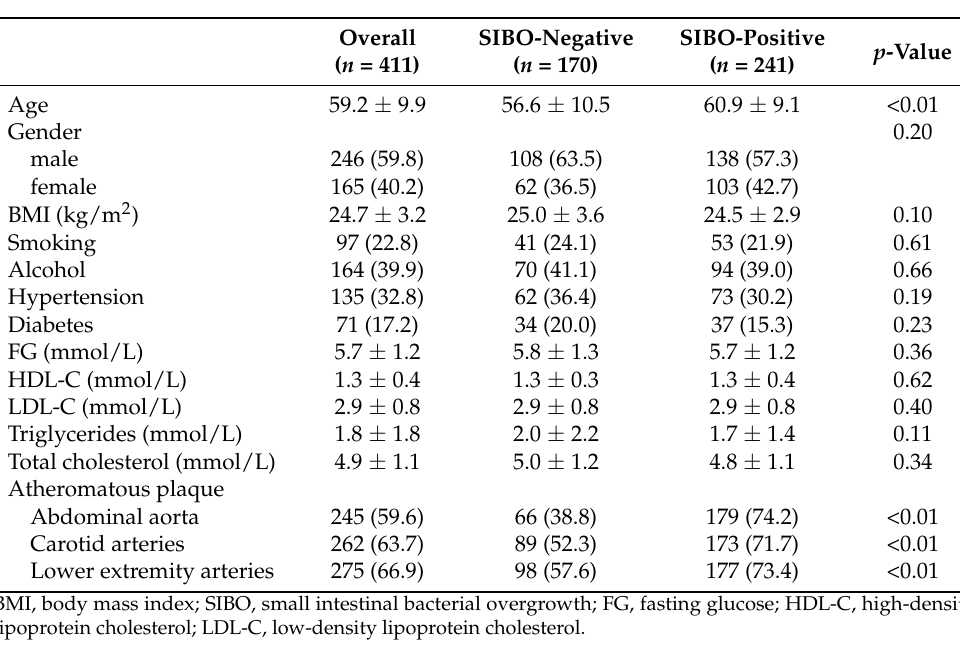
Table 1. Characteristics of demographic, biochemical, clinical and plaque presence in SIBO-positive and SIBO-negative groups.